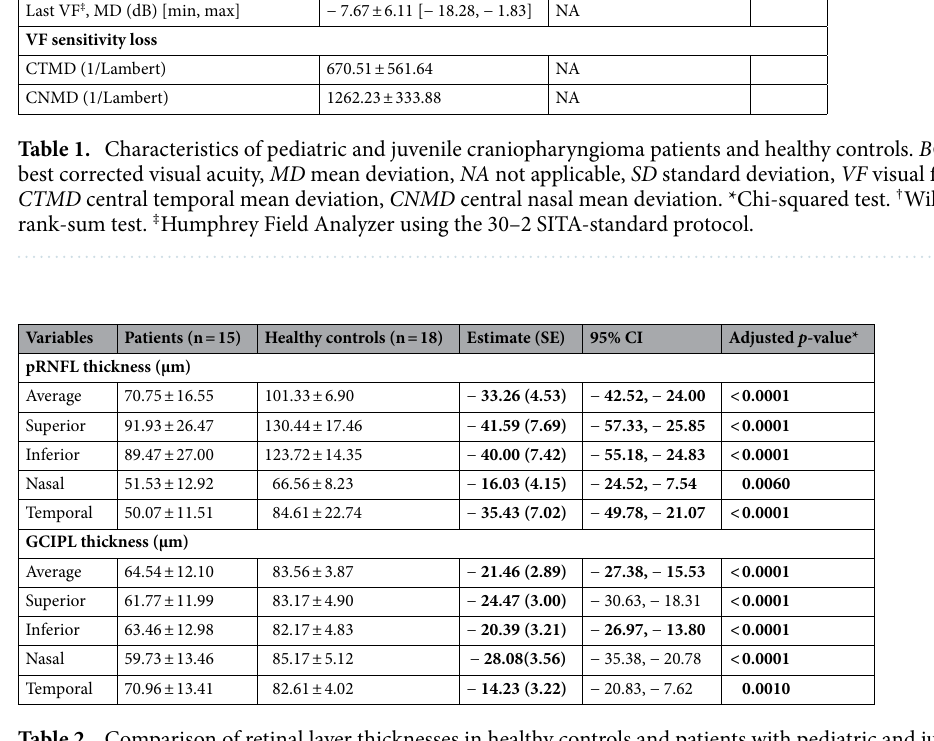
Table 2. Comparison of retinal layer thicknesses in healthy controls and patients with pediatric and juvenile craniopharyngioma. pRNFL peripapillary retinal nerve fiber layer, GCIPL ganglion cell-inner plexiform layer, SE standard error, CI confidence interval. Values are shown as mean ± standard deviation. * P- value was estimated by linear regression analysis with adjustments for age and spherical equivalent refractive errors and Bonferroni correction magnified by 10. Boldface indicates statistical